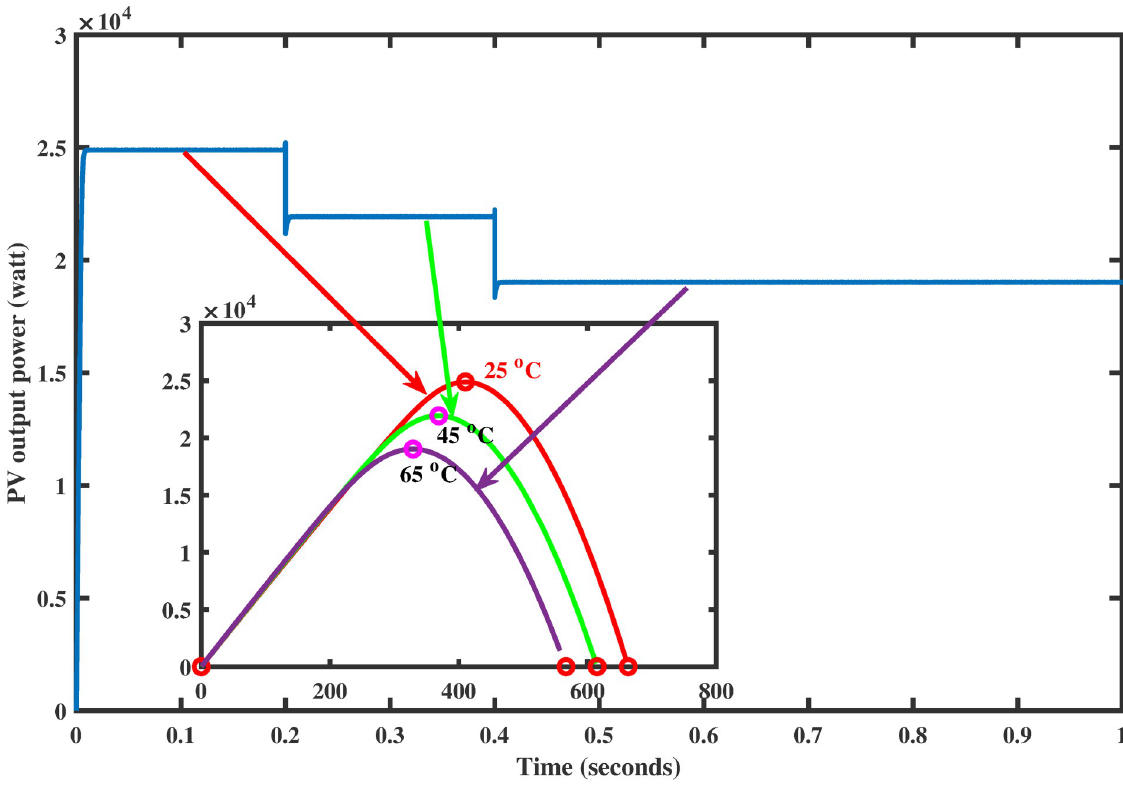
Fig 16. PV array power under varying temperature.